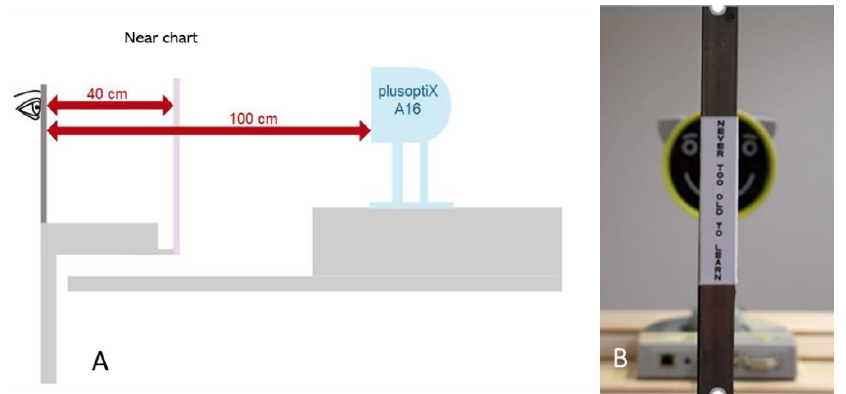
Figure 1. Setup to acquire accommodation data. Both eyes looked through binoculars either into the distance or at the movable near chart. The acquisition of the data with the autorefractor was simultaneous in both eyes under the binocular condition. ( A ) Setup overview. ( B ) Movable near target at 40 cm as seen by the participant.